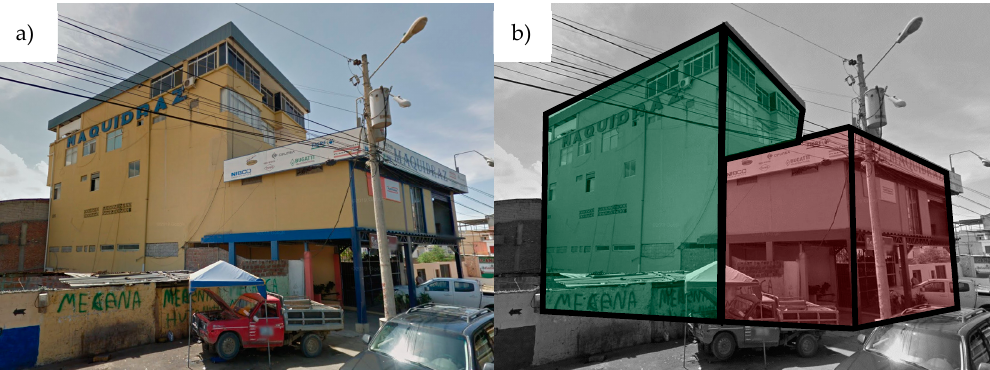
Figure 6. ( a ) Studied building. ( b ) In green, the main building used to build up the structural model and in red, the annex that was not considered in the structural model (pictures taken from Google Maps street view).